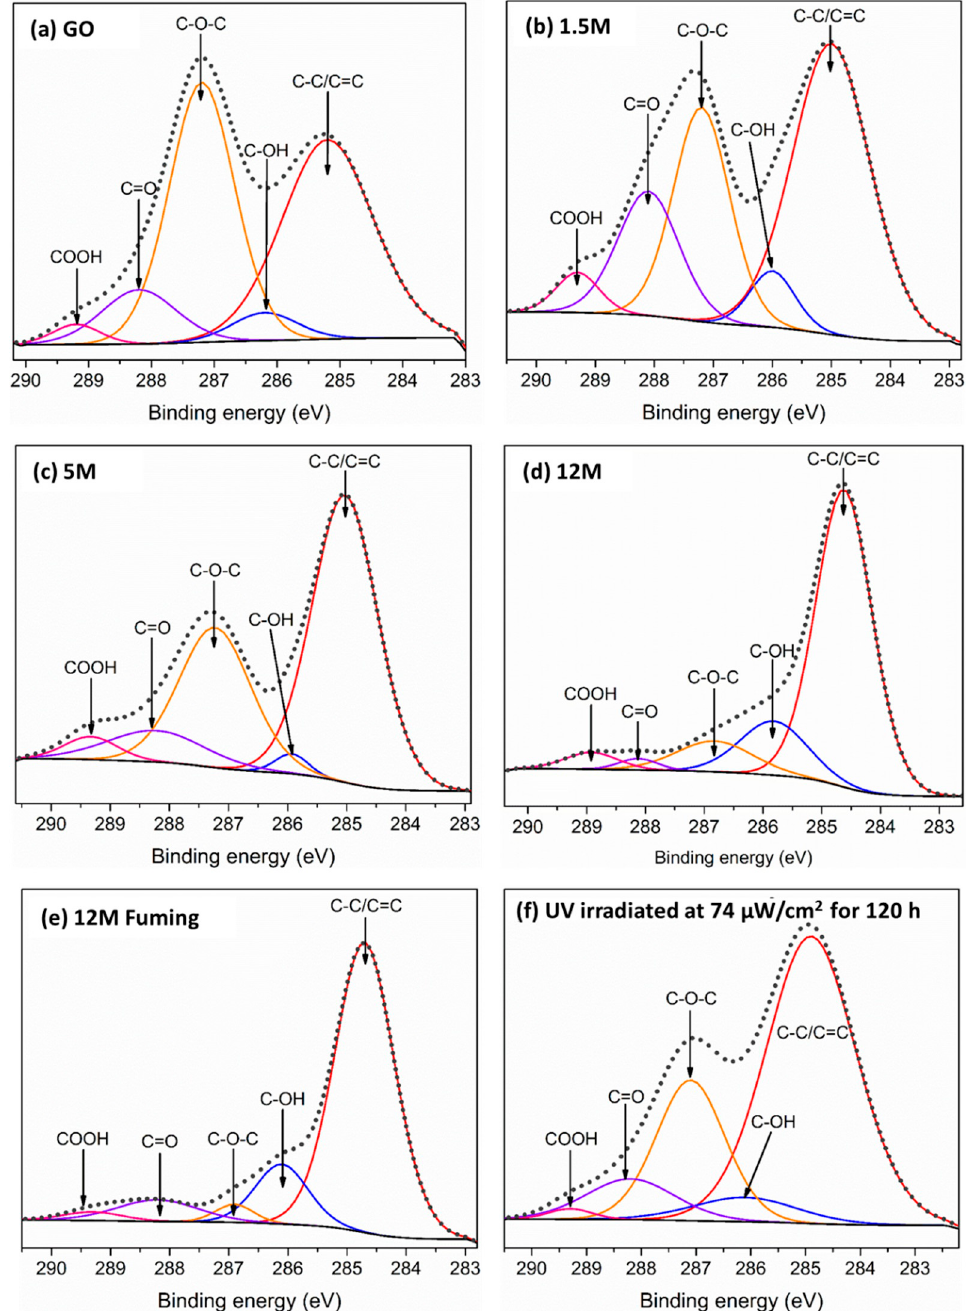
Figure 2. XPS spectra of ( a ) as-produced GO and RGO with H 2 SO 4 in ( b ) 1.5 M, ( c ) 5 M, and ( d ) 12 M concentrations; ( e ) RGO with fuming H 2 SO 4 in 12 M concentration; and ( f ) RGO irradiated at 74 μ W/cm 2 for 120 h.